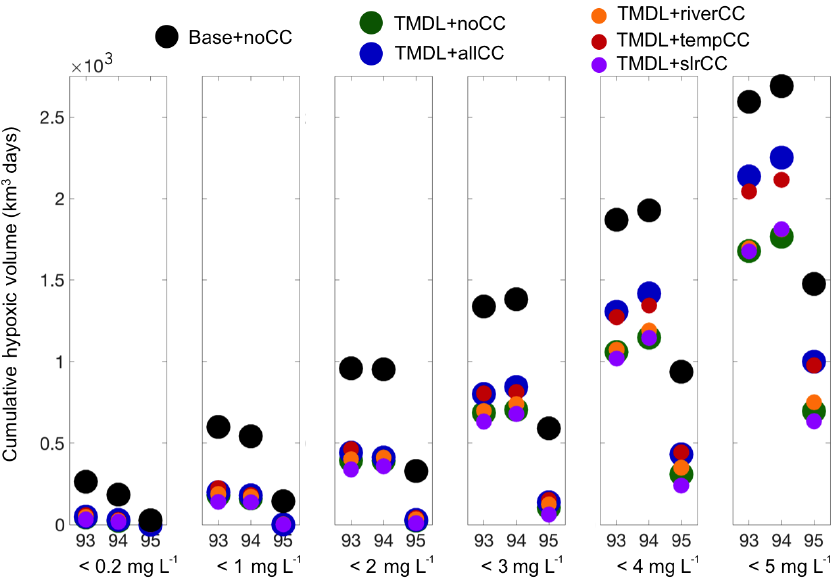
Figure 4. Cumulative hypoxic volume for six ranges of DO concentrations for each of the study years and each of the scenarios (colored